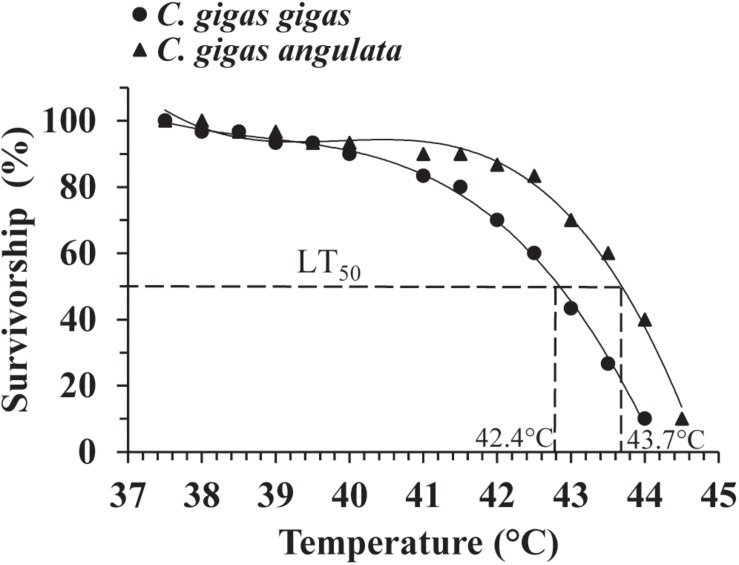
Upper LT50 in Crassostrea gigas gigas (circles) and C. gigas angulata (triangles). Data were fit with third order regression for modeling LT50.